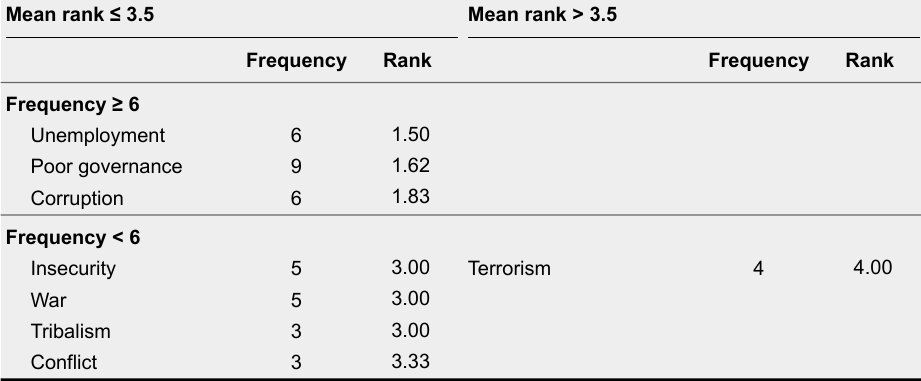
Structure of Risk Representation for Coastal Participants According to Free-Association Analysis (EVOC)